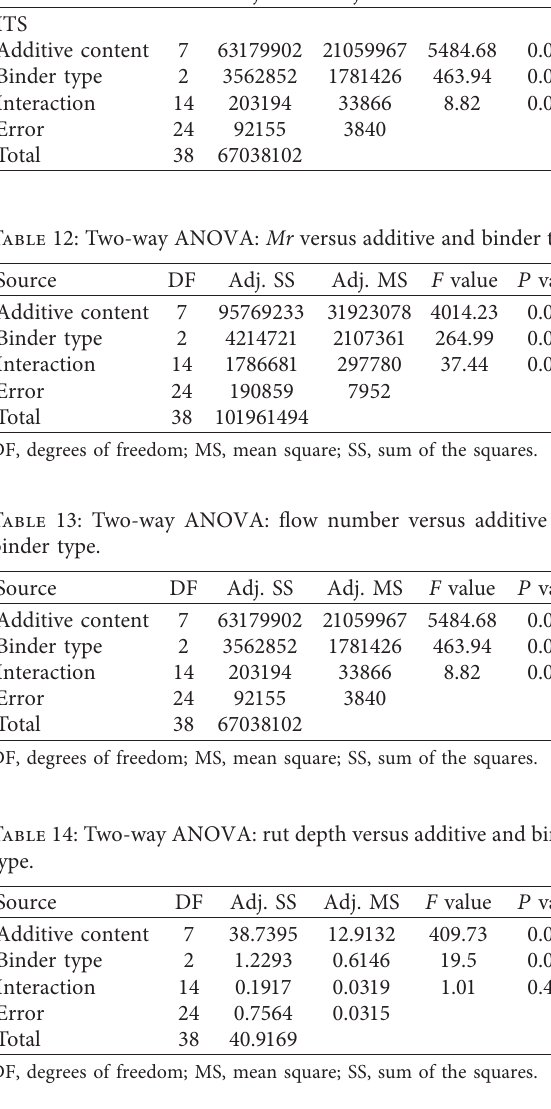
Table 11: Two-way ANOVA: ITS versus additive and binder type. Source DF Adj. SS